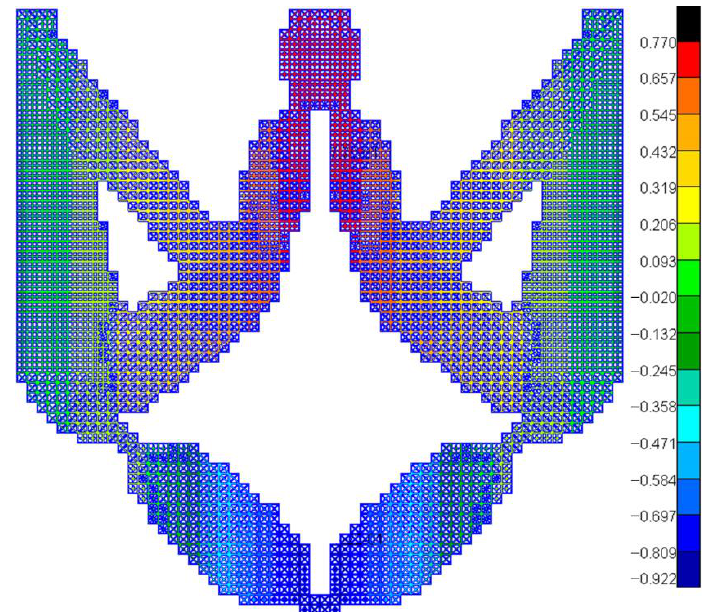
Figure 8. Vertical deformation fringe for HL-DIM with OLMs.